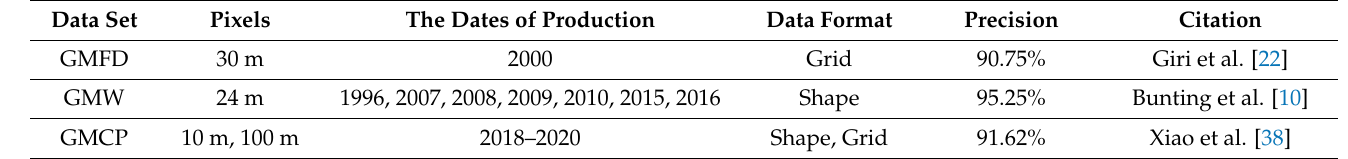
Table 3. The basic information of free download data